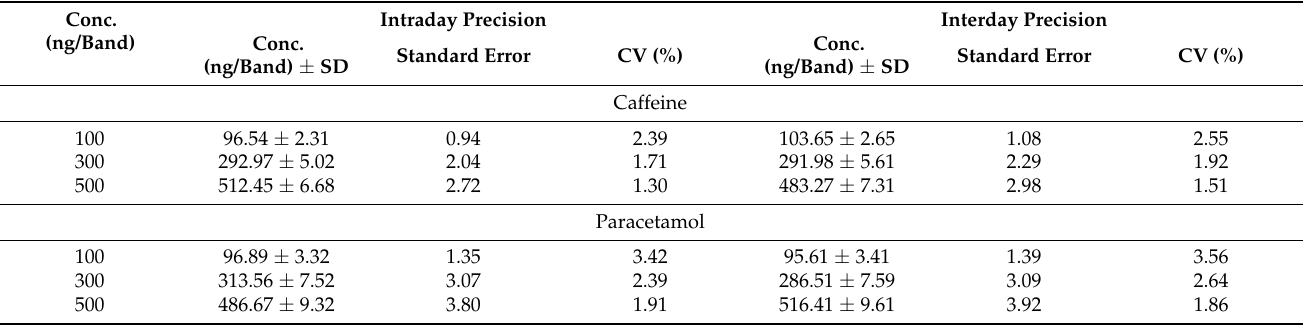
Table 7. Assessment of intra/inter-day precision of caffeine and paracetamol for the greener normal- phase HPTLC method (mean ± SD; n = 6).